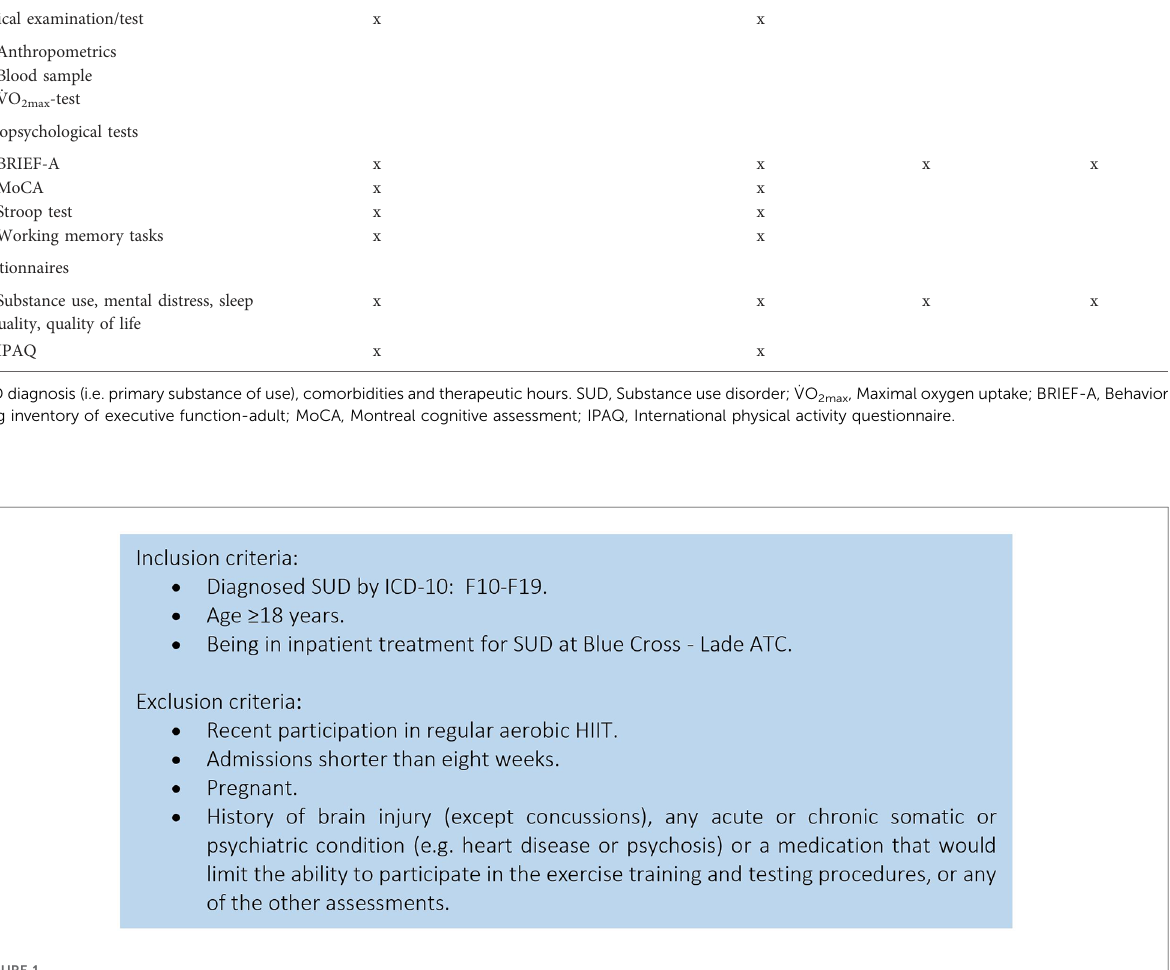
Pre- Intervention (eight intervention weeks)